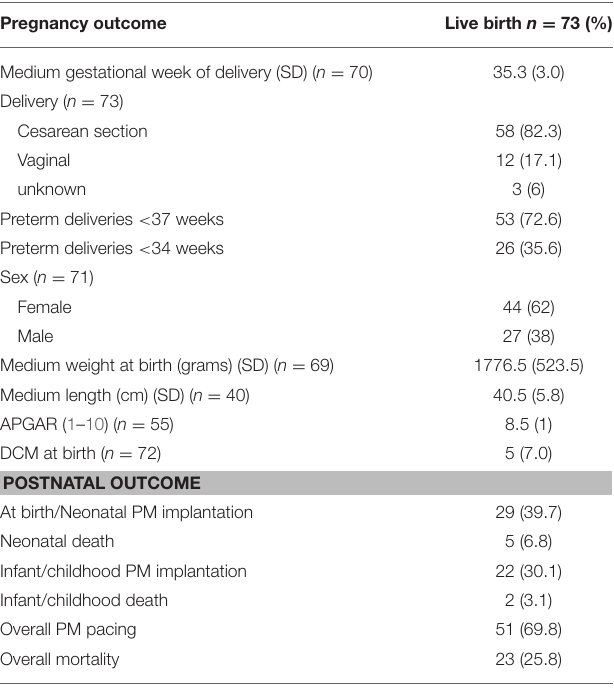
TABLE 6 | Pregnancy outcome and postnatal follow-up in pregnancies ended with a live birth. Pregnancy